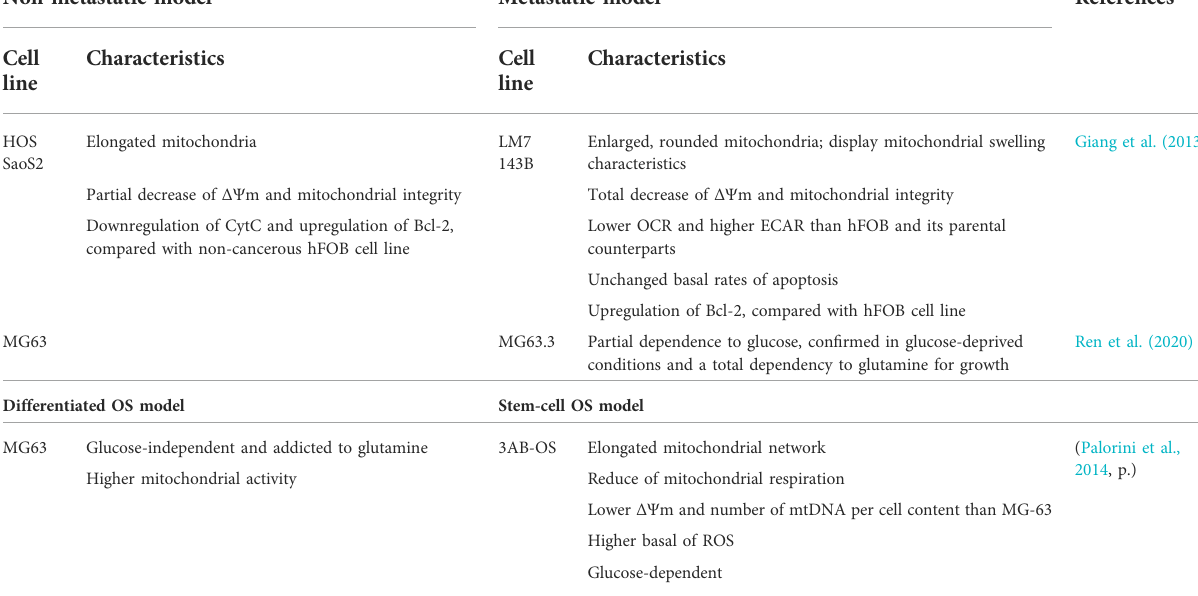
TABLE 1 Characteristics of dysregulated energy metabolism and substrate energy use in OS